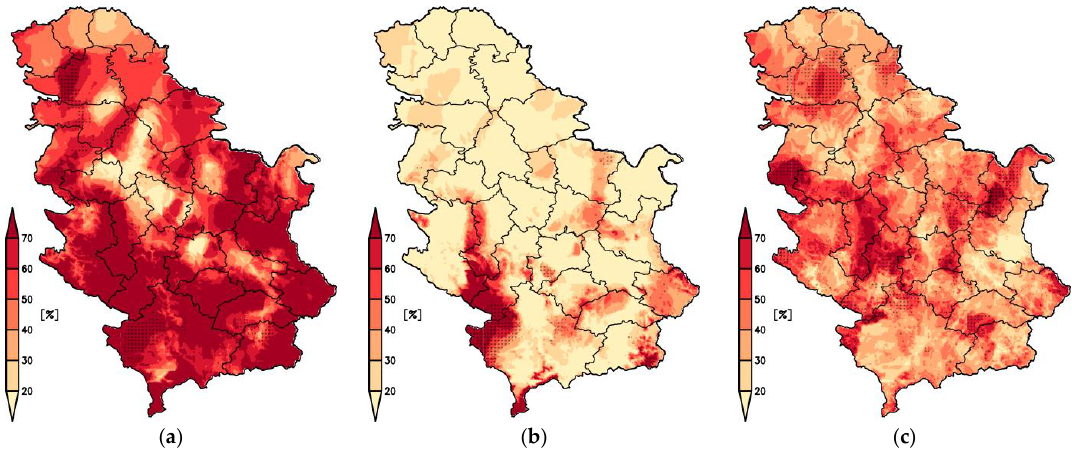
Figure 8. Frequency of years in which at least one occurrence of Tn < −15 °C ( a ), Tn < −20 °C ( b ), and daily precipitation above 30 mm during cherry ripening ( c ). Black dots mark areas where the frequency has increased more than 10% between the periods 1998–2017 and 1961–1990.